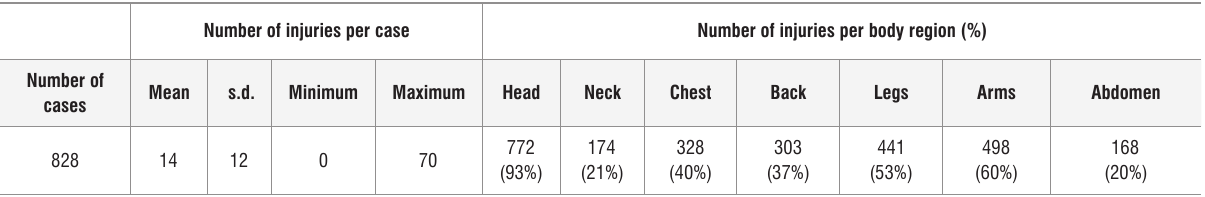
Table 4: Distribution of the number of external blunt force injuries per case from 2010 to 2014 and the regional distribution of the blunt force injuries Number of injuries per case Number of injuries per body region